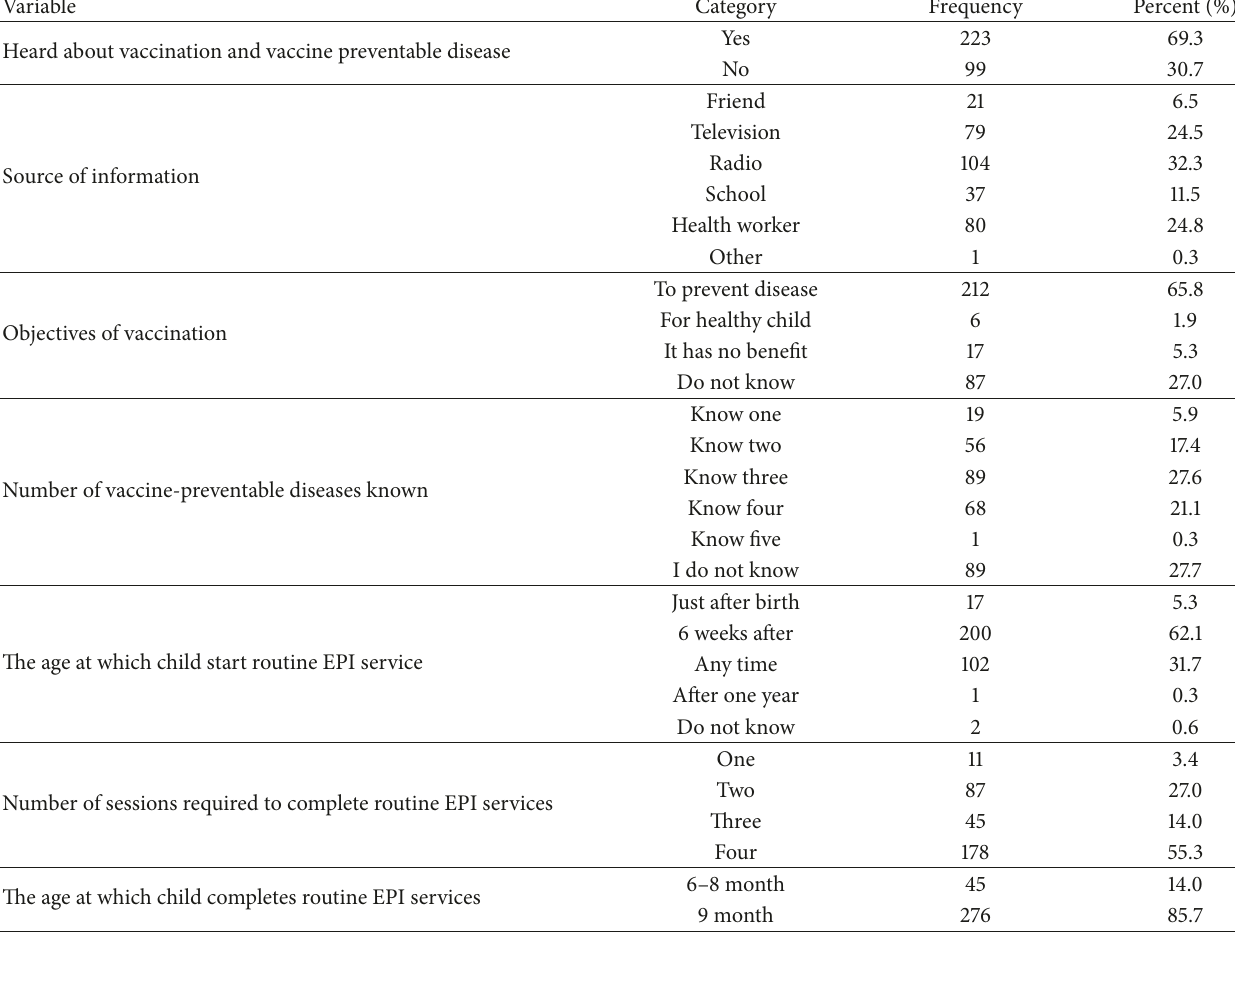
Table 3: Respondents knowledge on vaccination and vaccine-preventable diseases at Mizan Aman town, Bench Maji zone, Southwest Ethiopia, 2017.